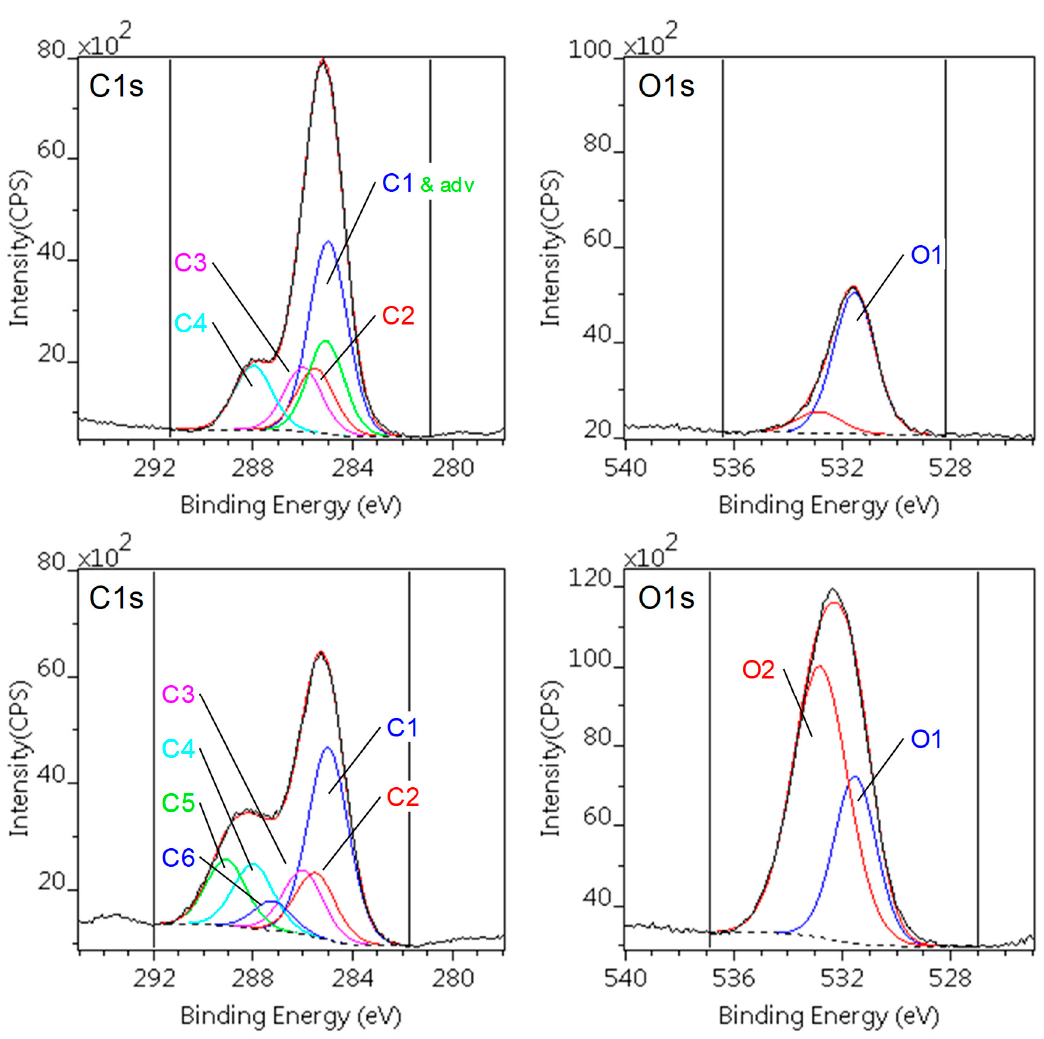
Figure 2. C1s and O1s photoelectron spectra of the pristine (upper) and DCSBD treated (lower) PA66 sample. On the untreated sample the C1 component coincides with the adventitious carbon.